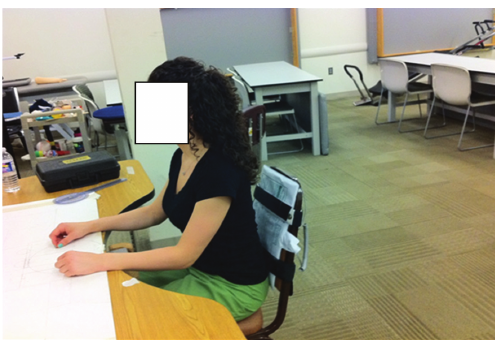
Figure 1: TRT workstation with sensor pad placed on anterior surface of chair back.